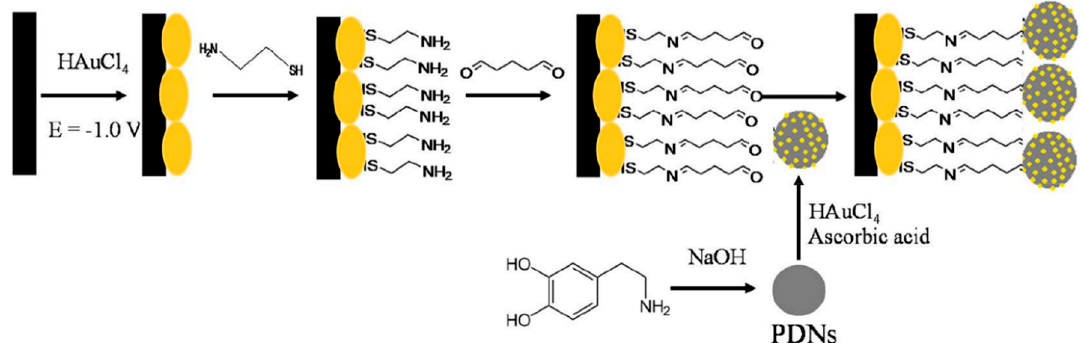
Figure 9. Schematic representation of the fabrication process of Au-PDNs (polydopamine nanospheres) electrodes. Repro- duced with permission from [128]. Copyright 2019 Elsevier B.V.